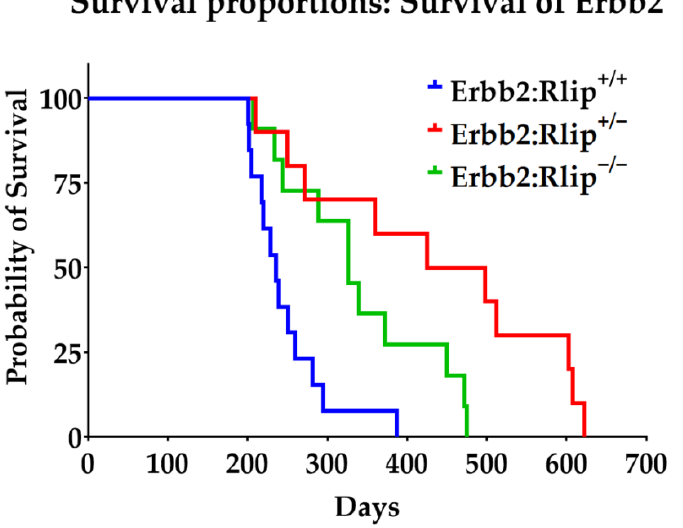
Figure 2. Rlip deficiency prevents spontaneous carcinogenesis in the MMTV-Erbb2 mouse model. Overall survival curves for mice of the indicated genotypes are shown. No treatment was given, and the mice were euthanized when tumor volume reached 2000 mm 3 . Results are reported as mean ± SD ( Erbb2:Rlip +/+ ( n = 13); Erbb2:Rlip −/− ( n = 10) and Erbb2:Rlip +/− ( n = 11)).